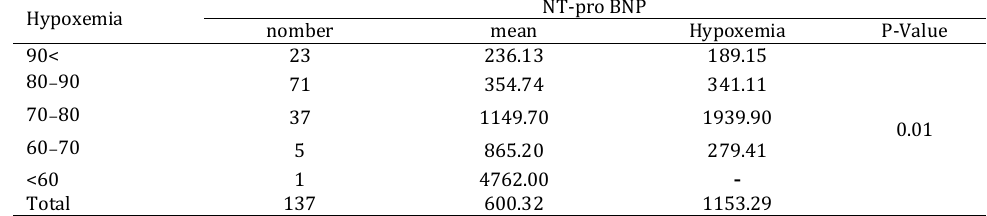
Table 1. The level of serum NT-pro BNP according to severity of Hypoxemia